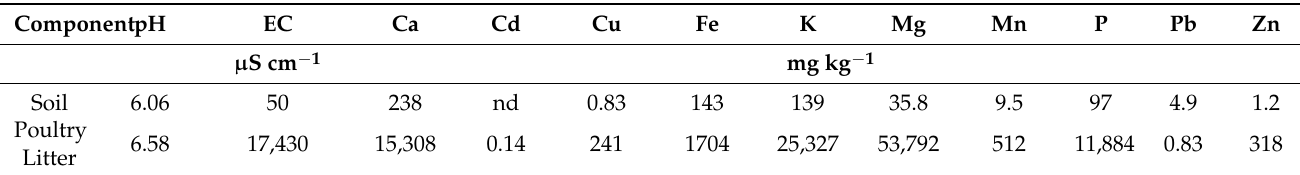
Table 1. Initial experimental plot analysis for soil and poultry litter.